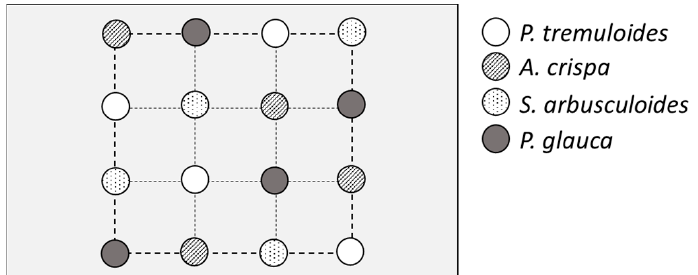
Figure 1. Tree seedling plantation arrangements. The seedling positions are shown using colored circles (gray shading), and the color legend shows di ff erent species.